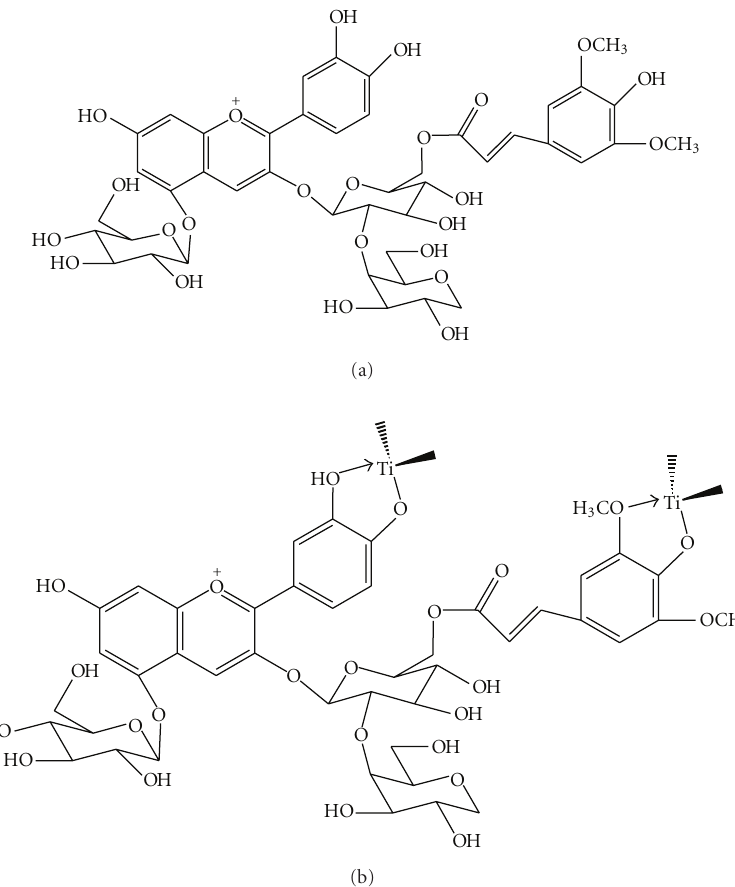
Figure 7: (a) Molecular structure of cyanidin-3-(sinapoyl)diglucoside-5-glucoside mainly found in red cabbage and (b) complexation between anthocyanin molecule and TiO 2